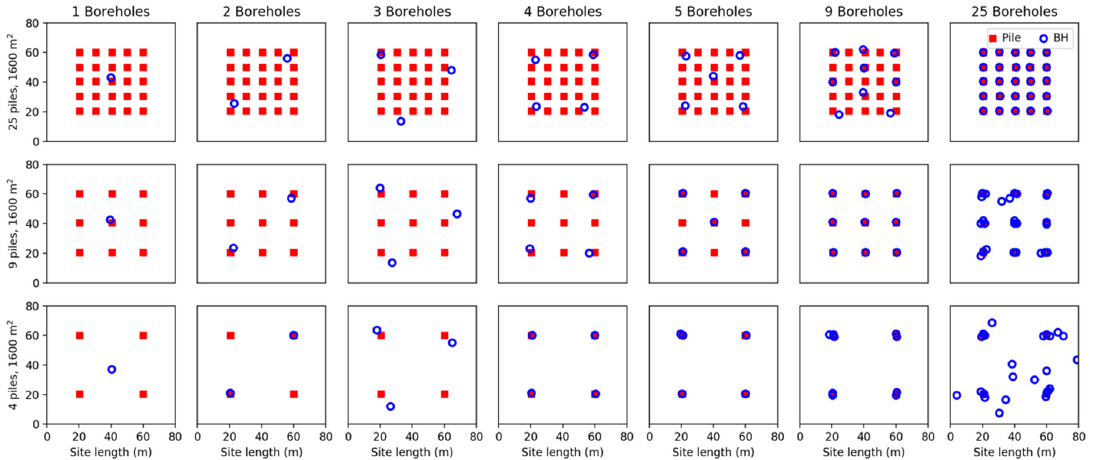
Figure 8. Optimal testing locations for different numbers of piles and boreholes for a two-layer soil with stiffness ratio 1:9 and boundary standard deviation of 2 m.